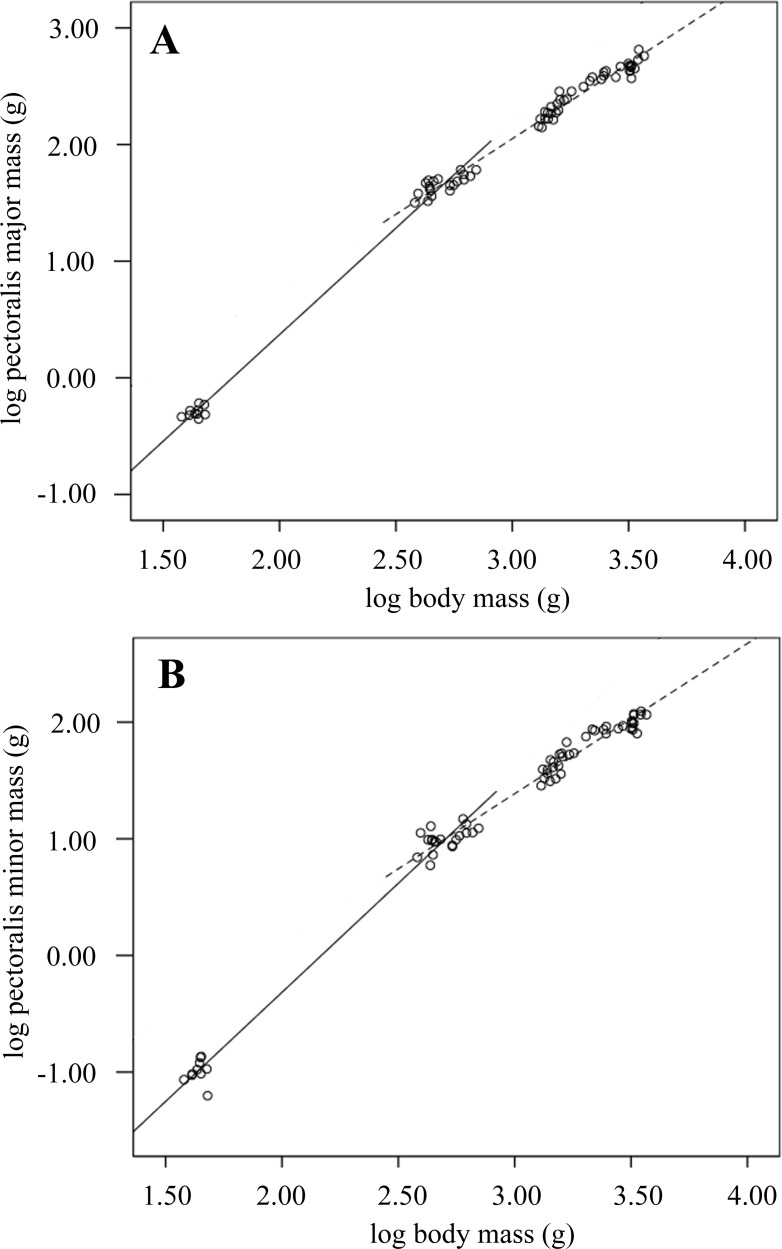
Breast muscle growth during development.Scatterplots showing log transformed pectoralis major and minor masses against log body mass over development from 0 to 2-weeks (solid line) and 2–6-weeks old (dashed line). The equations describing lines of best fit were: (A) pectoralis major 0–2 weeks: \documentclass[12pt]{minimal}
\usepackage{amsmath}
\usepackage{wasysym}
\usepackage{amsfonts}
\usepackage{amssymb}
\usepackage{amsbsy}
\usepackage{upgreek}
\usepackage{mathrsfs}
\setlength{\oddsidemargin}{-69pt}
\begin{document}
}{}${M}_{\mathrm{b}}^{1.83}$\end{document}Mb1.83–3.28 (n = 30, R2 = 0.99; p < 0.001); 2–6 weeks: \documentclass[12pt]{minimal}
\usepackage{amsmath}
\usepackage{wasysym}
\usepackage{amsfonts}
\usepackage{amssymb}
\usepackage{amsbsy}
\usepackage{upgreek}
\usepackage{mathrsfs}
\setlength{\oddsidemargin}{-69pt}
\begin{document}
}{}${M}_{\mathrm{b}}^{1.29}$\end{document}Mb1.29–1.83 (n = 59; R2 = 0.98; p < 0.001). (B) pectorals minor 0–2 weeks: \documentclass[12pt]{minimal}
\usepackage{amsmath}
\usepackage{wasysym}
\usepackage{amsfonts}
\usepackage{amssymb}
\usepackage{amsbsy}
\usepackage{upgreek}
\usepackage{mathrsfs}
\setlength{\oddsidemargin}{-69pt}
\begin{document}
}{}${M}_{\mathrm{b}}^{1.87}$\end{document}Mb1.87–4.06 (n = 30, R2 = 0.98; p < 0.001); 2–6 weeks: \documentclass[12pt]{minimal}
\usepackage{amsmath}
\usepackage{wasysym}
\usepackage{amsfonts}
\usepackage{amssymb}
\usepackage{amsbsy}
\usepackage{upgreek}
\usepackage{mathrsfs}
\setlength{\oddsidemargin}{-69pt}
\begin{document}
}{}${M}_{\mathrm{b}}^{1.28}$\end{document}Mb1.28–2.48 (n = 58; R2 = 0.96; p < 0.001).